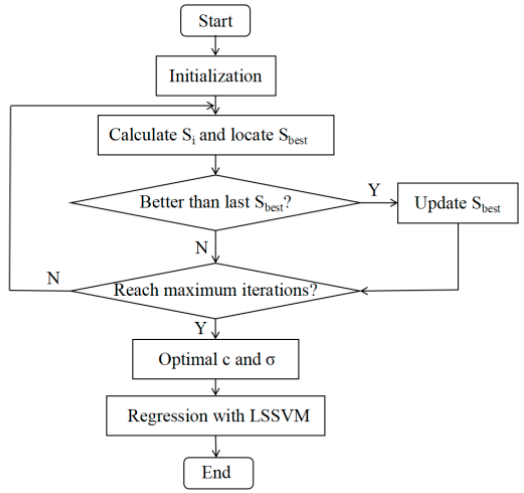
Figure 3. Temperature compensation flow using the FOA.